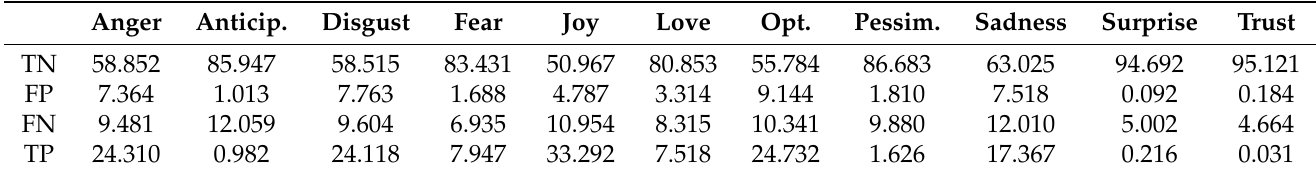
Table 4. Tabulated results of the confusion matrix for each emotion. We show the percentage of true negatives (TN), false positives (FP), false negatives (FN), and true positives (TP) per label. Anger Anticip.